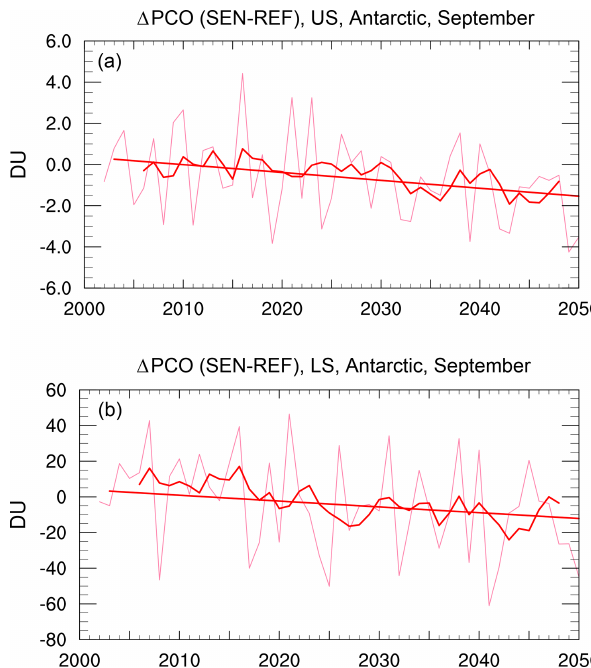
Figure 6. Temporal evolution of partial column ozone (PCO) differ- ences (in DU) between SEN-C2-fCFC11_2050 and REF-C2 (i.e., SEN minus REF) for the Antarctic region (70–90 ◦ S) in Septem- ber. Panel (a) shows PCO values for the US (above 30km); panel (b) shows PCO values for the LS (below 30km). Red thicker curves show the respective 5-year running means. The corresponding lines show the trend estimates for the unsmoothed time series using a multiple linear regression – including differences of temperature anomalies as the dependent variable – which accounts for possible autocorrelation with lag 1 (see text for